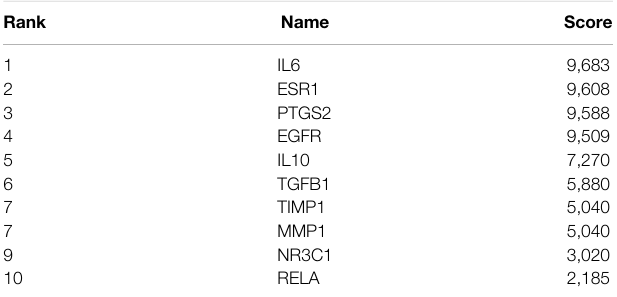
TABLE 2 | Top 10 genes in the protein – protein interaction network ranked by the maximal clique centrality method.